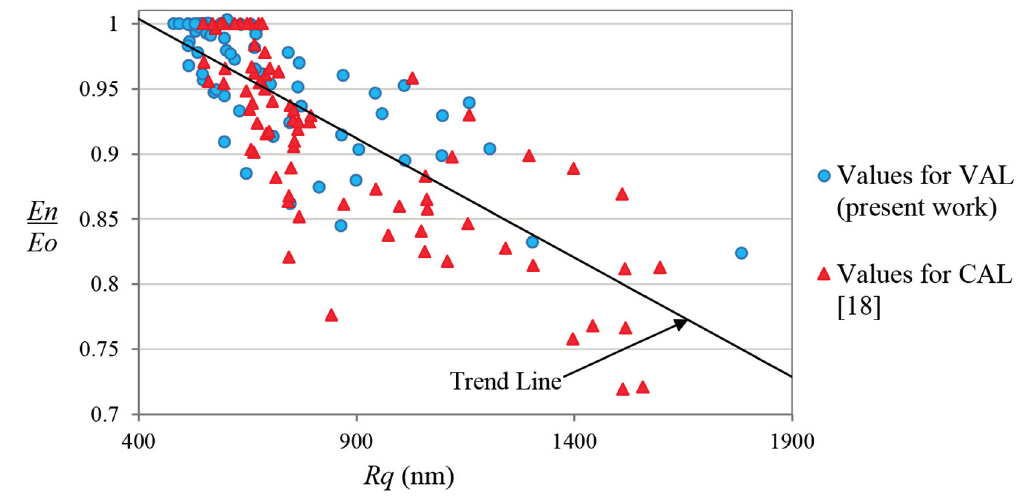
Figure 9. Comparison between the data obtained for VAL in the present work, and the data obtained for CAL in a previous study [18]. The trend line is obtained for the combination of both